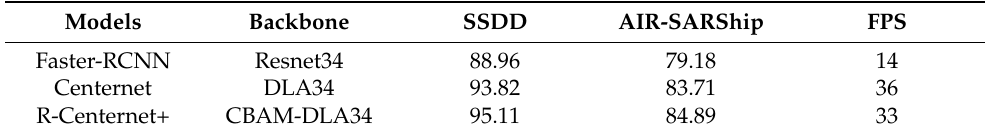
Table 10. Comparisons of detection performance with state-of-the-art models on SAR images.